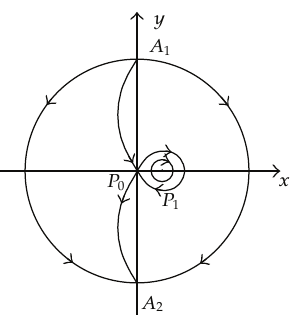
Figure 3: (cid:6) b > 0, c > 0 (cid:7)